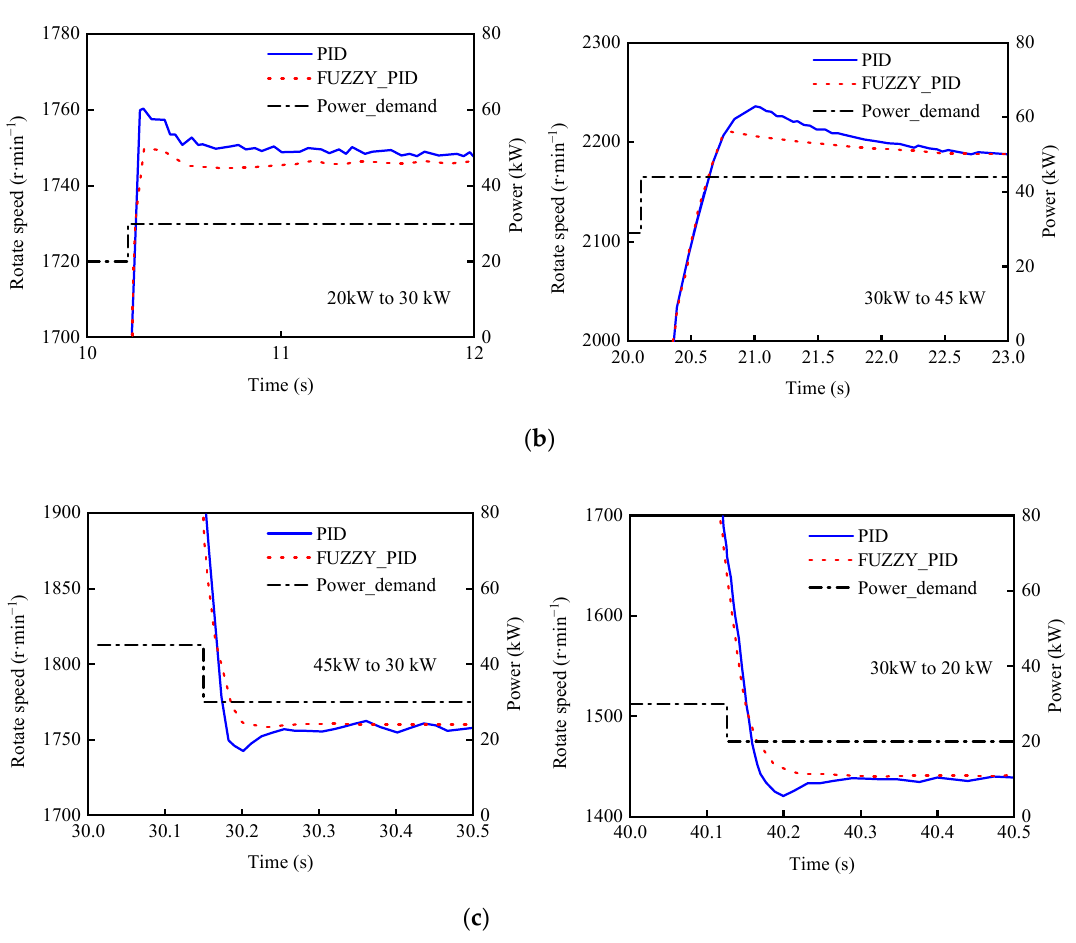
Figure 3. Simulation results of the range extender switching process: ( a ) Total switching process of the range extender; ( b ) The switching process of increasing the speed and torque with an increased power demand; ( c ) The switching process of speed and torque reduction with a power demand reduction.